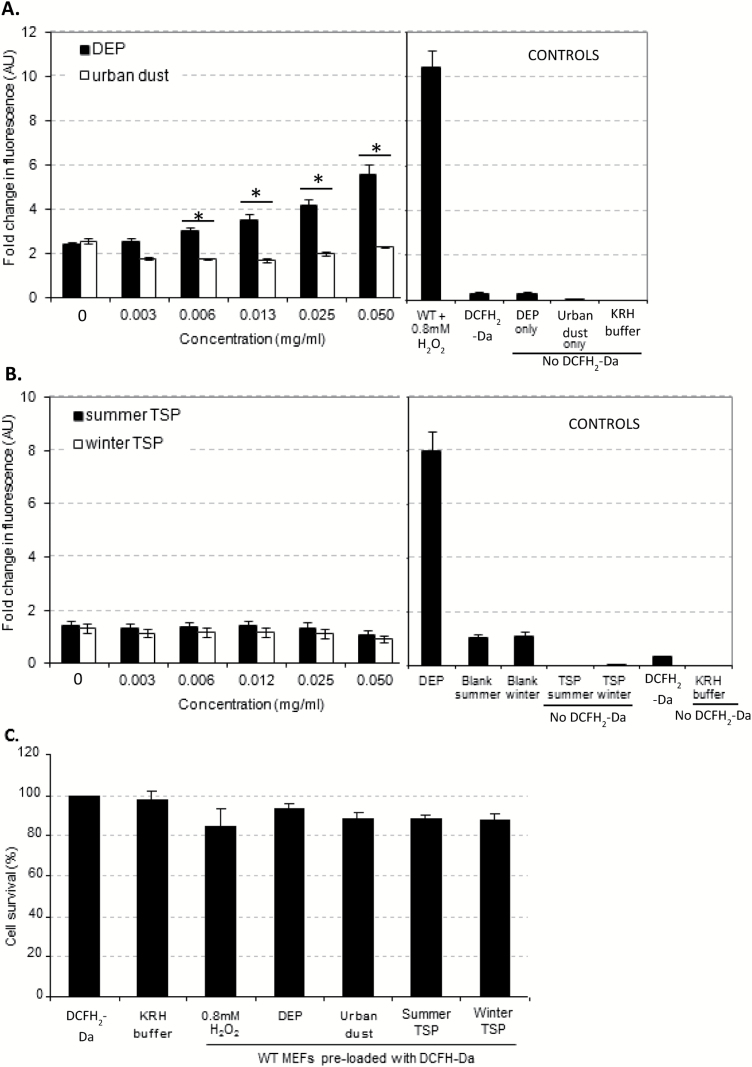
Mean intracellular ROS levels (A and B) and mean cytotoxicity (C) in MEFs following PM exposure. (A and B) MEFs were plated in 96-well plates and allowed to settle for 24h prior to incubation for 30min with 50 µM DCFH2-DA in KRH buffer in the dark. DCFH2-DA-containing buffer was subsequently removed and 0–50 µg/ml PM was added in triplicate wells [A: urban dust (SRM1649a) and DEP, B: summer and winter TSP]. Oxidation of DCFH2-DA to fluorescent DCF was measured every 5min for 2h on a fluorescent plate reader (λex 480nm, λem 530nm). Data presented in (A) and (B) was obtained after 45-min incubation with PM but a similar pattern was observed at each time point. Controls included: cells + DEP or H2O2 + DCFH2-DA (positive controls), DCFH2-DA only (without cells), KRH buffer and summer and winter TSP blanks + DCFH-DA. PM (50 µg/ml) in KRH buffer was added in triplicate wells without cells to check for autofluorescence. Results presented as mean ± SEM (n = 5), *P < 0.05 one-way analysis of variance (ANOVA). (C) Cytotoxicity of the highest PM dose used was subsequently assessed in DCFH2-DA-loaded MEFs, after 2-h incubation using the MTT assay. PM-containing buffer was replaced by 0.6mg/ml MTT and incubated for 2.5h. Formazan precipitate was then dissolved in DMSO before measurement of the absorbance at 570 and 690nm. Results presented as mean ± SEM (n = 4). P > 0.05 one-way ANOVA.